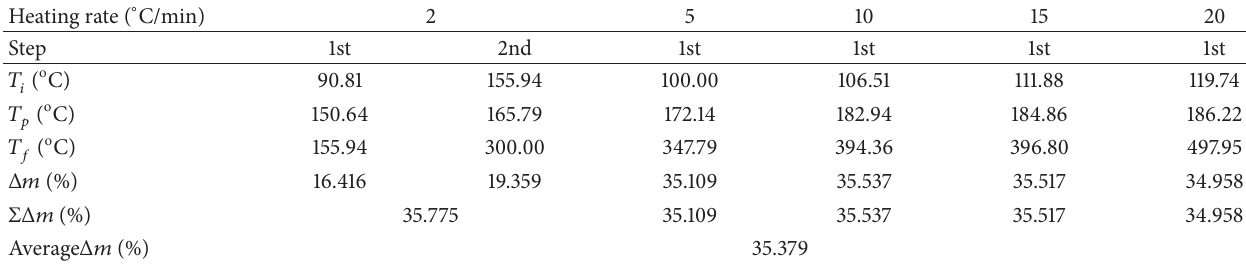
Table 3: Dehydration temperatures and weight losses of pure mcallisterite (MH-60-30).